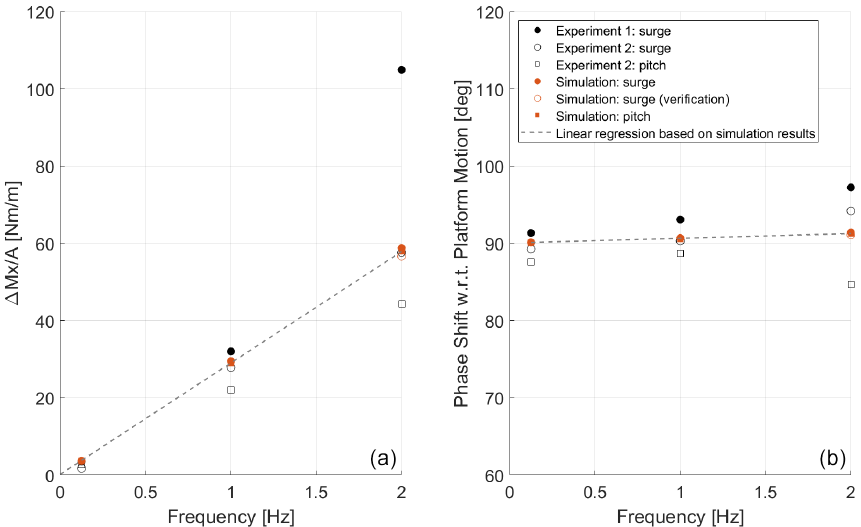
Figure 18. Normalized aerodynamic rotor torque variation and phase shift with regard to platform motion during unsteady wind conditions using load cases from 2.1 to 3.7 (excluding Load Cases 2.16 and